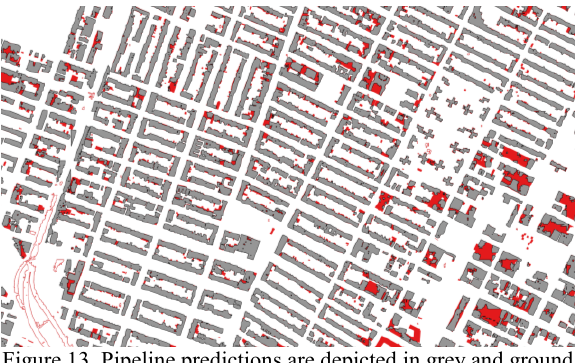
Figure 13. Pipeline predictions are depicted in grey and ground truth in red. FP outlines are shown in red using model b1_2_128 in Table